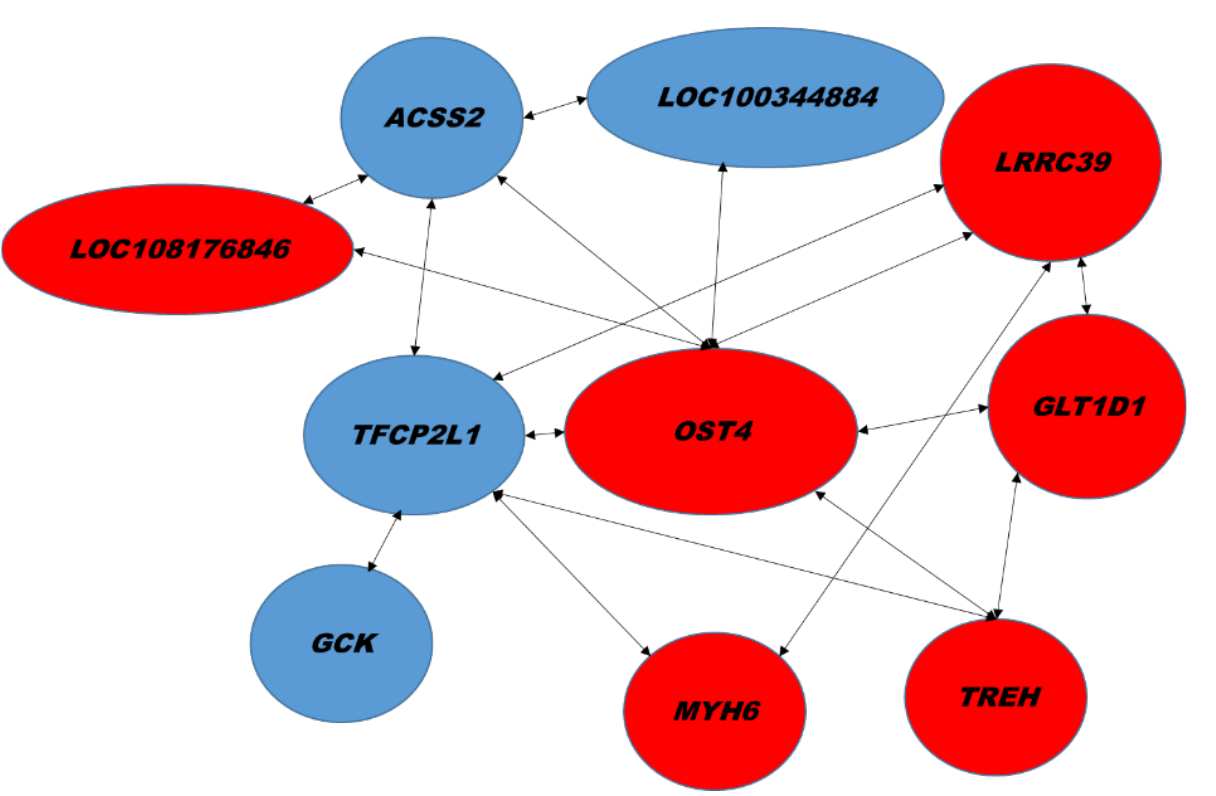
Figure 6. Network of hepatic transcripts. A, Association among transcript changes assayed by RT-qPCR. Red, up regulation. Blue, down regulation. Significant Spearman ’ s correlations ( p < 0.02).